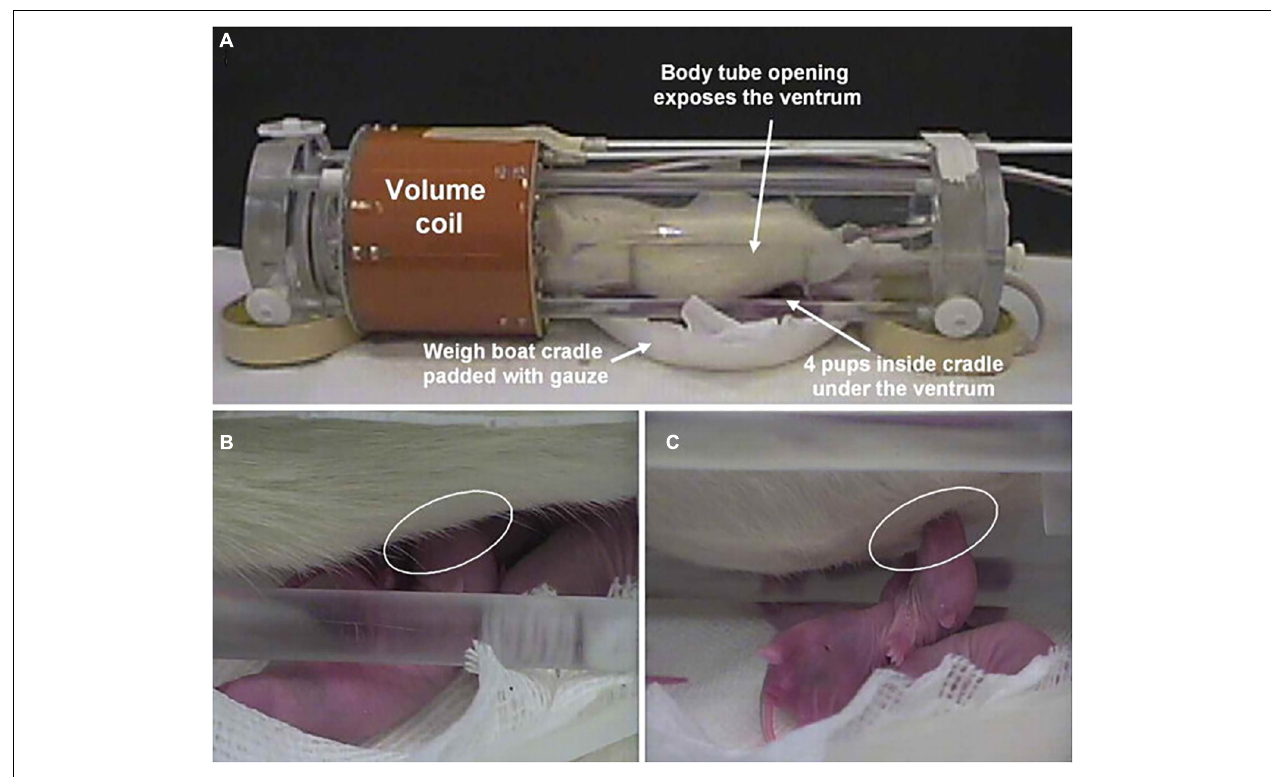
FIGURE 3 | Setting for pup suckling in the magnet. Shown is the experimental setup for imaging pup suckling during the scanning session of awake dams. (A) The opening in the body tube allowing pups to gain access to the dam for nursing. Pups are in a cradle beneath the dam. (B) Pup suckling is established within seconds during a functional scan. (C) Side view showing a suckling pup. (Adapted with permission from Febo et al.